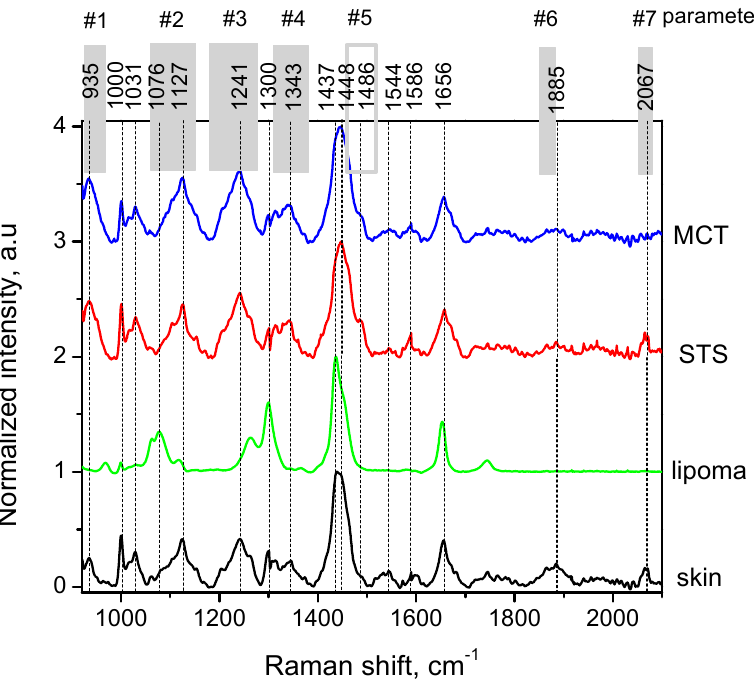
Figure 6. Mean normalized Raman spectra of skin, lipomas, soft tissue sarcomas (STS), and mast cell tumors (MCT). Native skin was present in 31 samples (adjacent to: lipoma—5; MCT—9; STS—17 samples). Gray areas mark the ranges of Raman spectra parameters #1 to #7 (abbreviated as p1—p7). For clarity, an offset of +1 in the y-axis was introduced for each tumor spectrum. Malignant STS and MCT possessed common Raman peaks compared to healthy skin.